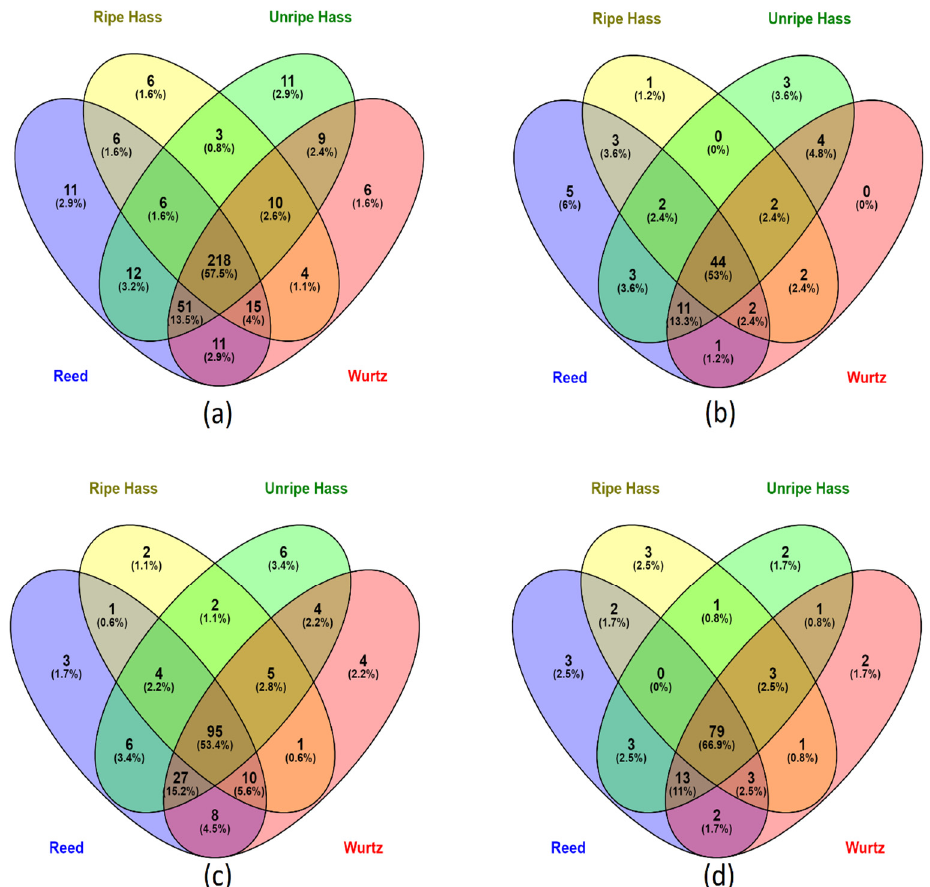
Figure 1. Venn diagram of screened phenolic compounds species present in various avocado varieties. ( a ) distribution of all the screened phenolic compounds in all avocado parts (peel, pulp and seed) from the four varieties. ( b ) distribution of phenolic acids in all parts of the four avocado varieties. ( c ) distribution of flavonoids in all parts of the four avocado varieties. ( d ) distribution of other polyphenols (including lignans and stilbenes) in all parts of the four avocado varieties.